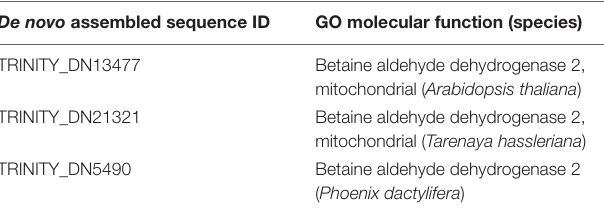
TABLE 5 | Putative betaine aldehyde dehydrogenases genes present in the transcriptome of Chlorominima collina